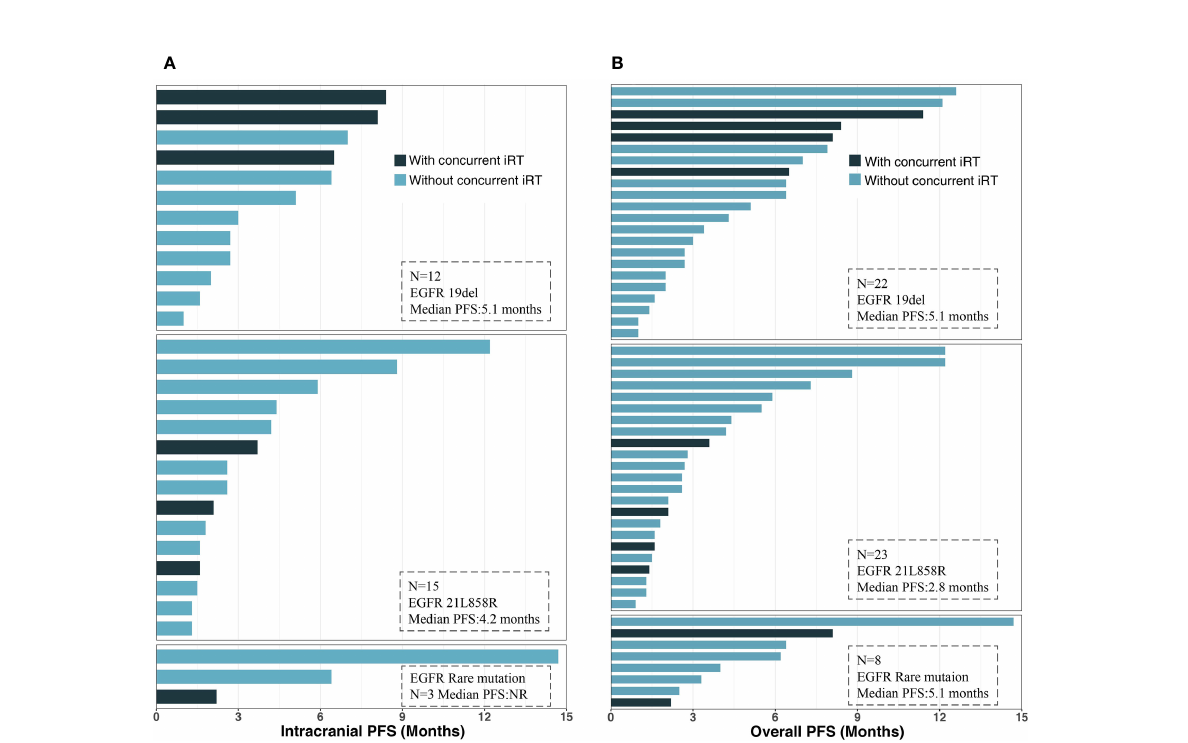
FIGURE 5 Intracranial and overall PFS for subgroups with different gene mutation types: (A) intracranial PFS. (B) Overall PFS. PFS, progression-free survival; iRT, intracranial radiotherapy; EGFR, epidermal growth factor